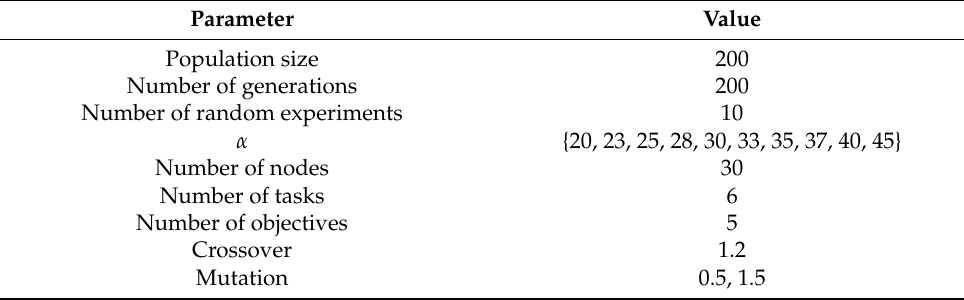
Table 6. Table of parameters used for evaluation FCCL